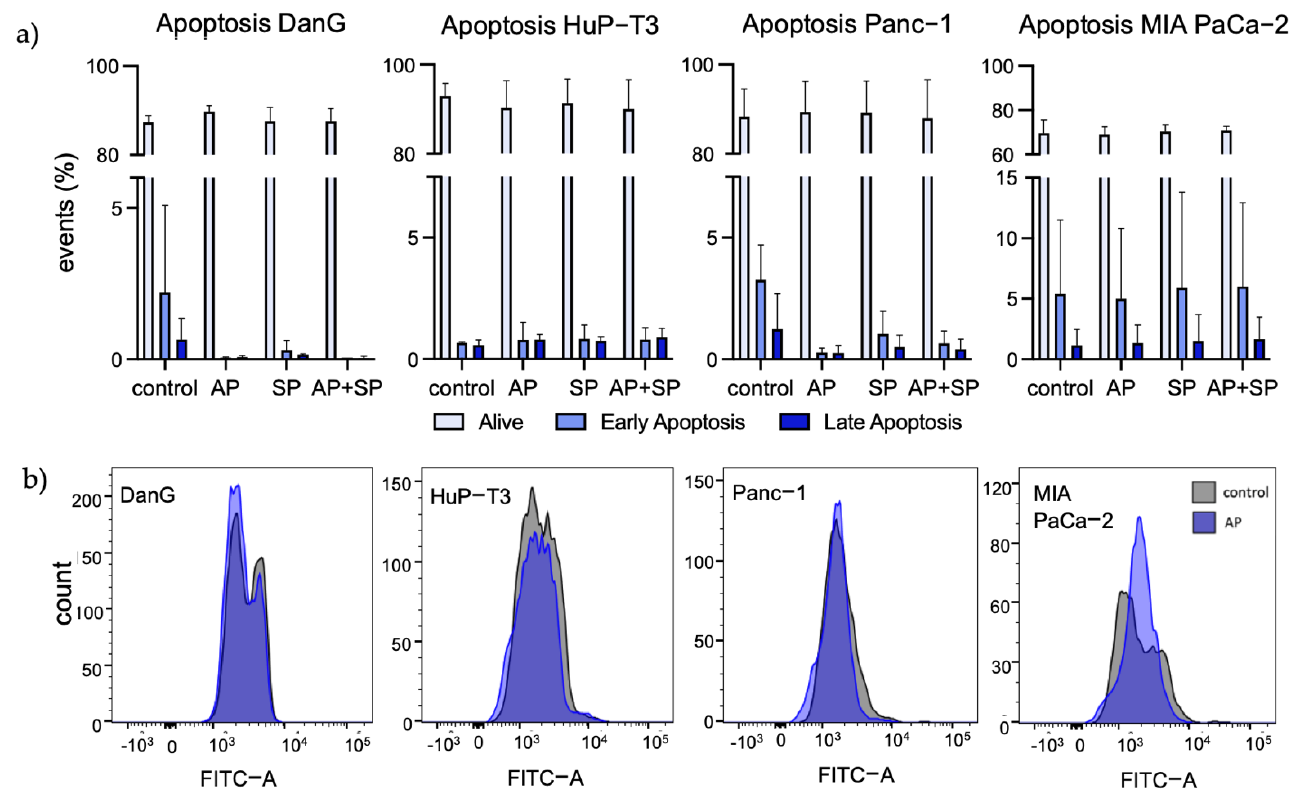
Figure 4. Apoptosis detection and caspase detection analysis. ( a ) FITC Annexin V/PI flow cytometry for detection of AP-mediated apoptosis in untreated and SP-treated cells. Drugs were applied in the following concentrations: AP 25 µM and SP 20 nM. Statistical analysis revealed no significant differences between treatments regarding Annexin V-positive cells. ( b ) FITC-VAD-FMK accumulation in the indicated cell lines measured via flow cytometry. Slight left shift after AP-treatment indicates small, but not significant changes in intracellular caspase activation. Bar charts and univariate histogram sorted left to right from epithelial to mesenchymal transition state.